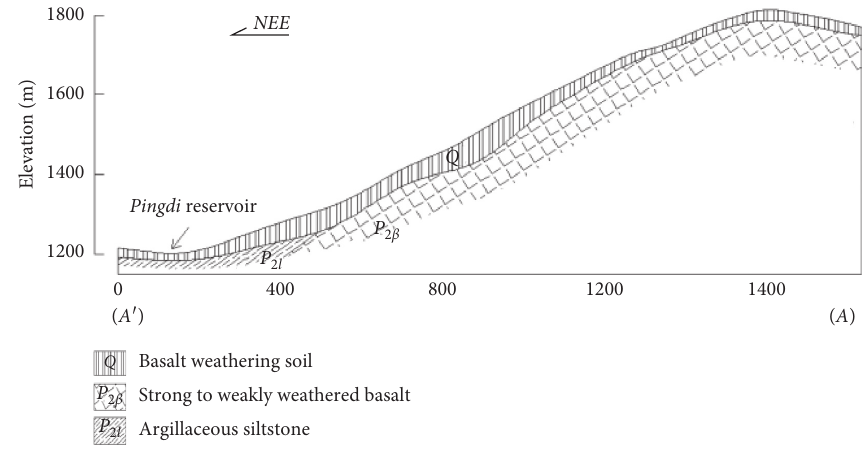
Figure 4: Cross section A-A’ of the Jichang slope. Table 2: Physical-mechanical properties of the red weathered-basalt